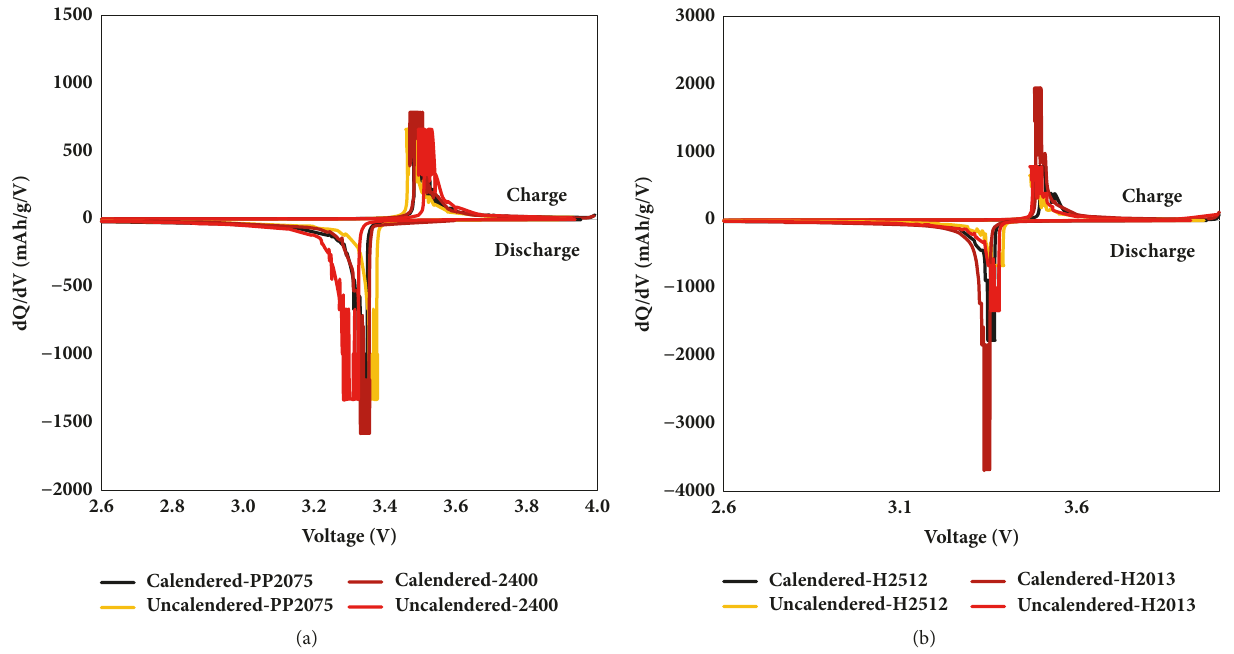
Figure 5: dQ/dV versus voltage curve of both charge and discharge data of (a) monolayer separators and (b) trilayer separators.